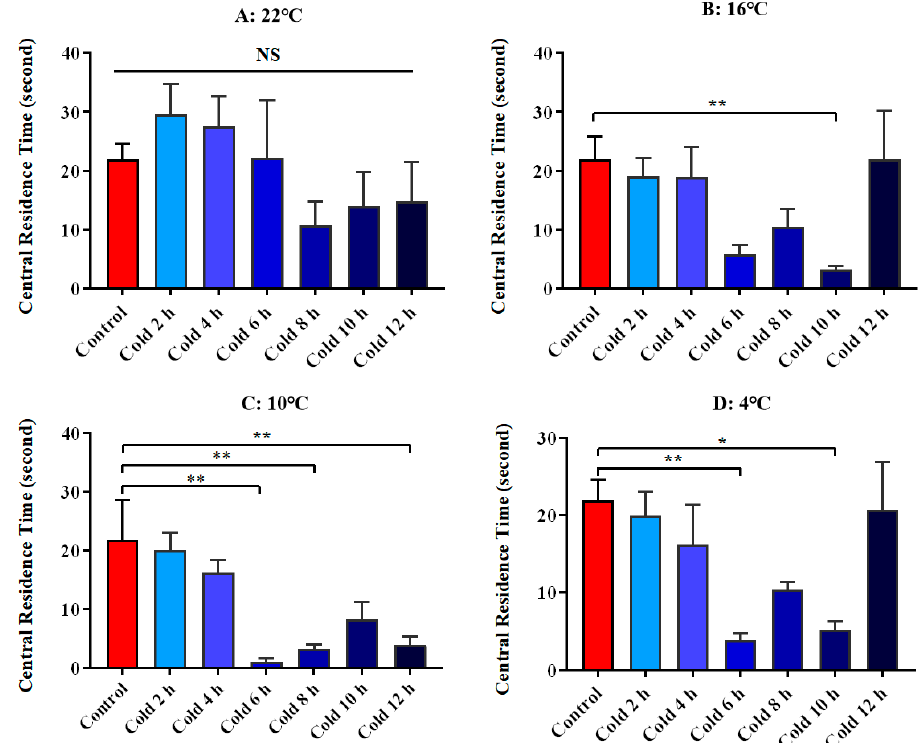
Figure 4. Changes in exploratory behavior of ICR mice under different intensity of cold exposure. ( A ). Changes in the central residence time of mice under cold exposure at 22 ◦ C; ( B ). Changes in the central residence time of mice under cold exposure at 16 ◦ C; ( C ). Changes in the central residence time of mice under cold exposure at 10 ◦ C; ( D ). Change in the central residence time of mice under cold exposure at 4 ◦ C. Compared with 28 ◦ C normal temperature control group, the difference was significant as * p < 0.05. ** p < 0.01.